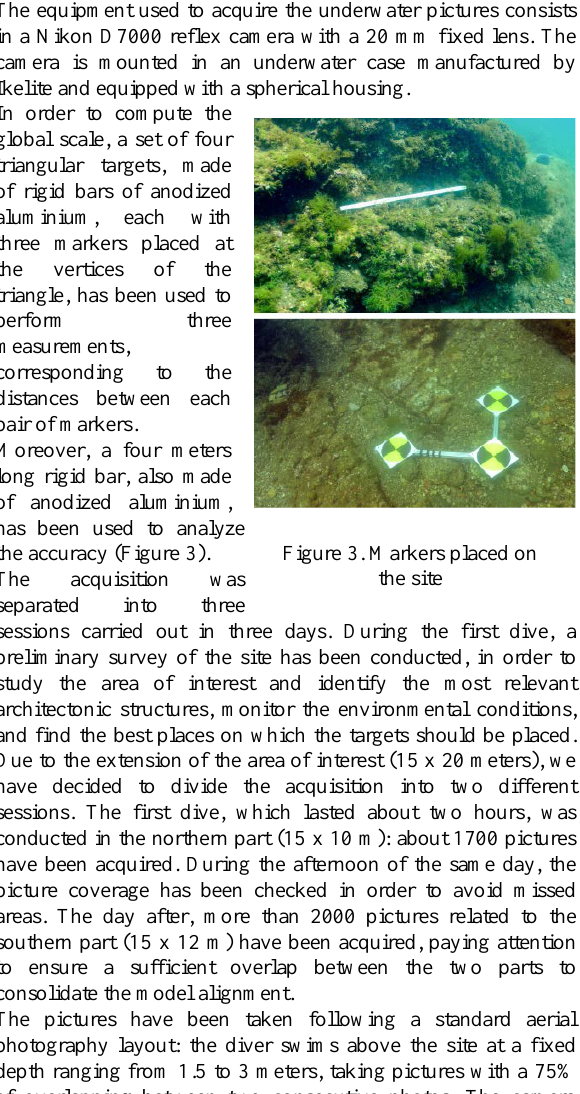
Vertical walls and features which are occluded in aerial pictures, have been acquired using a series of oblique photographs taken swimming around each feature.